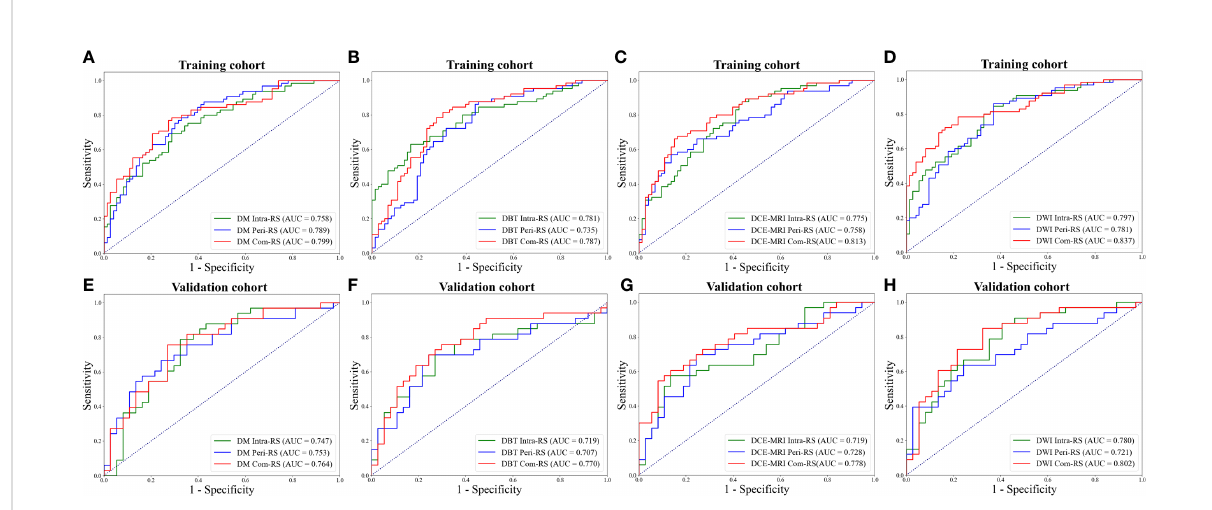
FIGURE 3 ROC curves of each developed RS. (A, E) ROC curves for the RSs from DM. (B, F) ROC curves for the RSs from DBT. (C, G) ROC curves for the RSs from DCE-MRI. (D, H) ROC curves for the RSs from DWI. The above row represents ROC curves in the training cohort, whereas the bottom row represents ROC curves in the validation